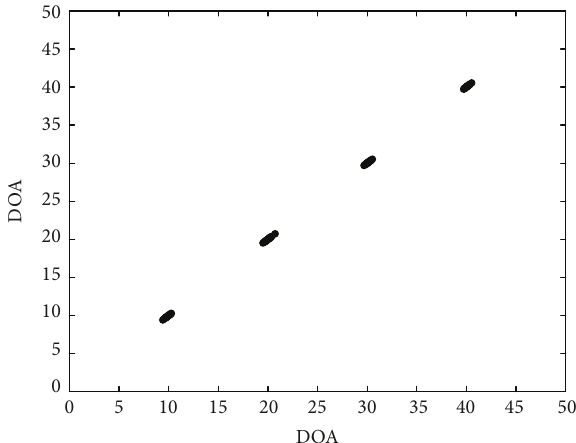
Figure 2: Angle estimation result for 30 independent trials with SNR = 5dB .